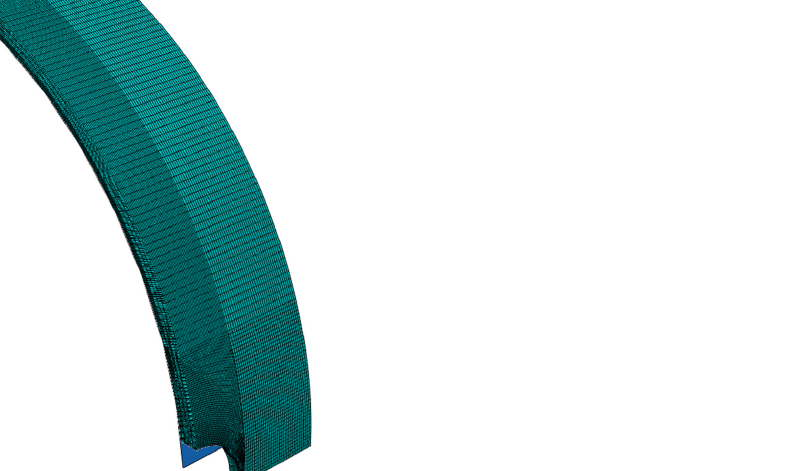
Figure 13. D Model of 1/8 of the split disk. The disk is represented by the rigid surface under the laminate.